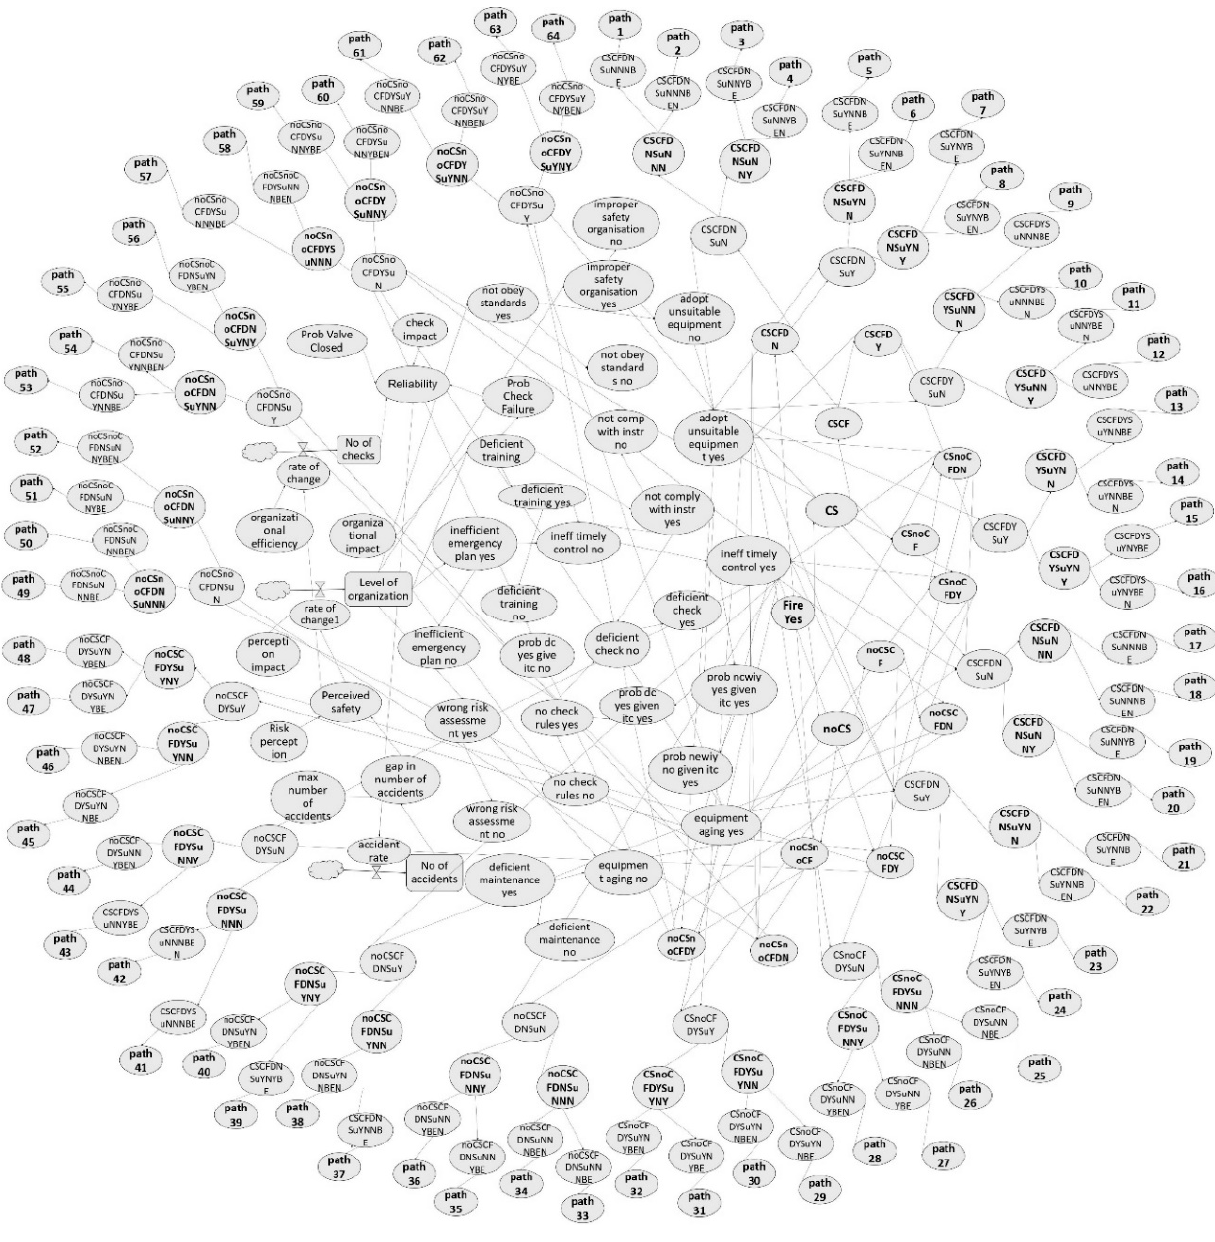
Figure A5. Mapped System Dynamics Model.